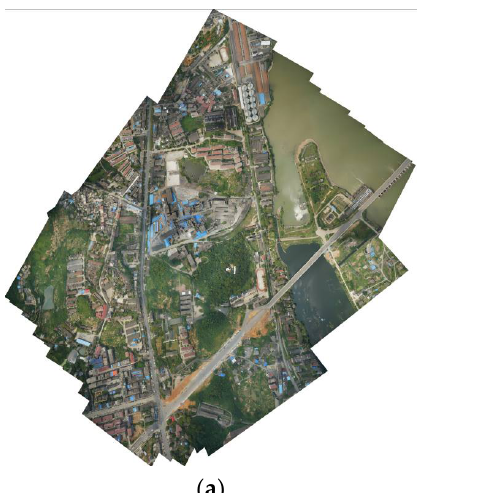
Figure 5. Mosaicking result of Dataset 1: ( a ) mosaicking result via Capel’s method; and ( b ) mosaicking result using the proposed algorithm.